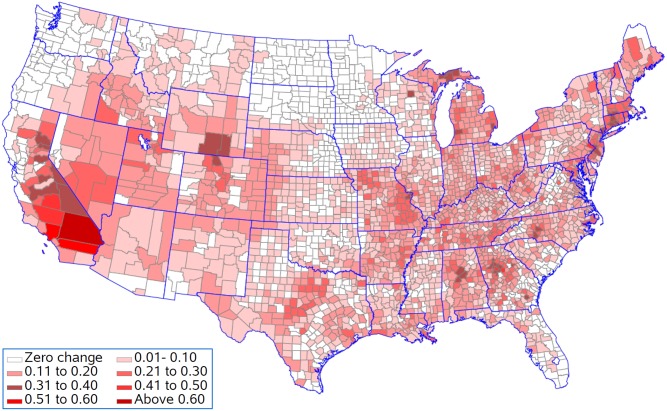
Reduction in life expectancy (years lost) resulting from being above the regional 25th percentile for each pollutant.